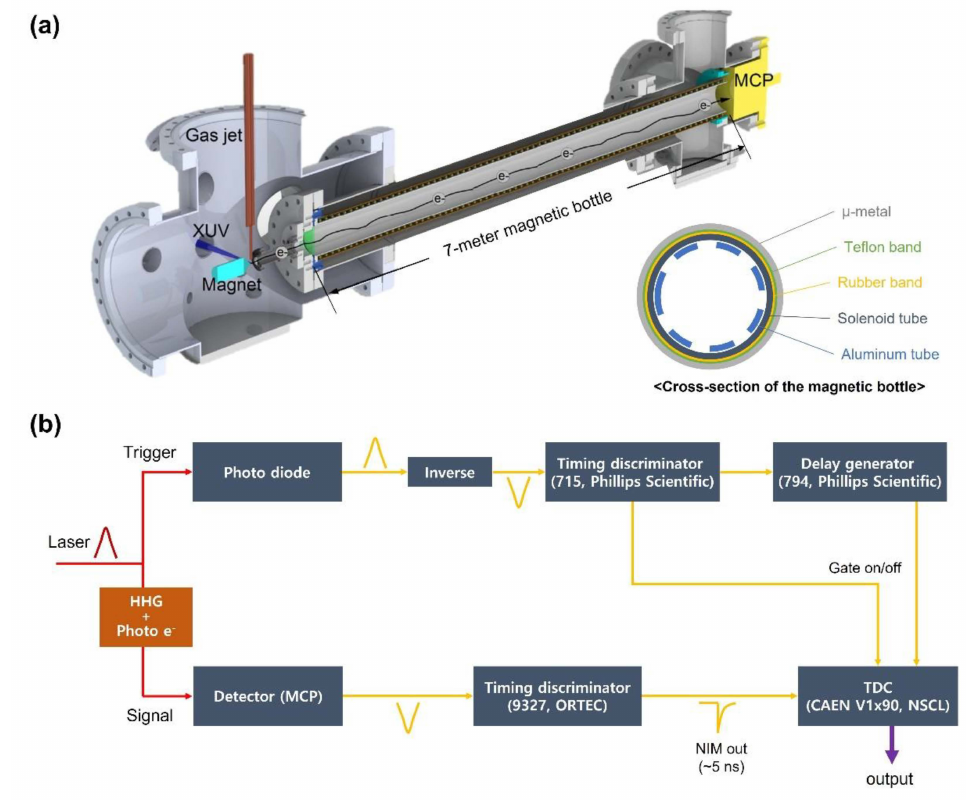
Figure 5. High resolution electron time-of-flight spectrometer. ( a ) Diagram of the magnetic bottle electron spectrometer with a seven-meter-long flight tube [29]. The XUV beam is focused between a magnet and an aperture of the spectrometer. A gas jet is placed on top of the focusing spot of the XUV beam. Generated photoelectrons enter the aperture of the spectrometer and propagate through the seven-meter-long tube then detected by a MCP detector. ( b ) Data process for measuring the photoelectron